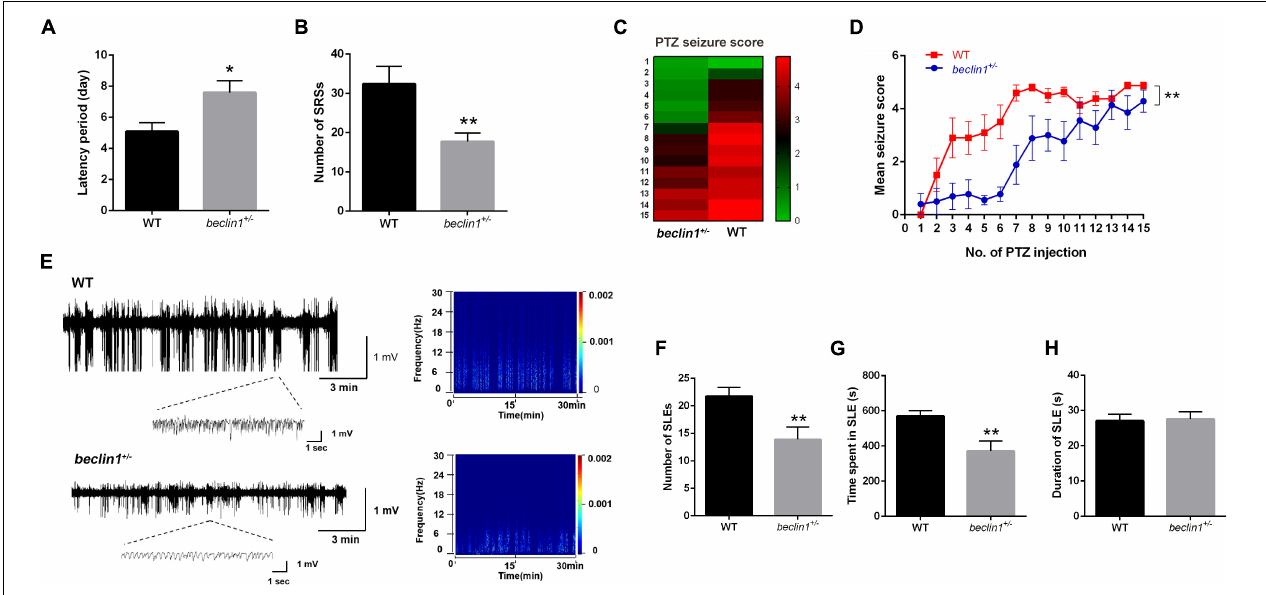
FIGURE 3 | Knockdown of beclin1 decreased seizure susceptibility and epileptic activity. (A,B) Quantitative analysis of the spontaneous recurrent seizure (SRS) latency and total number of SRSs in the kainic acid (KA)-induced epilepsy model in the two groups ( n = 10 mice per group). (C,D) Mean seizure scores recorded after the injection of pentylenetetrazol (PTZ) in the two groups on alternate days ( n = 10 mice per group). (E) Representative traces of local field potentials (LFPs) from the wild-type (WT) and beclin1 ± groups. (F–H) Quantitative analysis of the number, time spent, and duration of seizure-like event (SLE) of the LFPs from two groups ( n = 8 mice per group). Data are presented as the means ± SEM. * p < 0.05 and ** p < 0.01. Group differences in the mean seizure score during PTZ kindling were evaluated with repeated-measures ANOVA. Student’s t -tests were